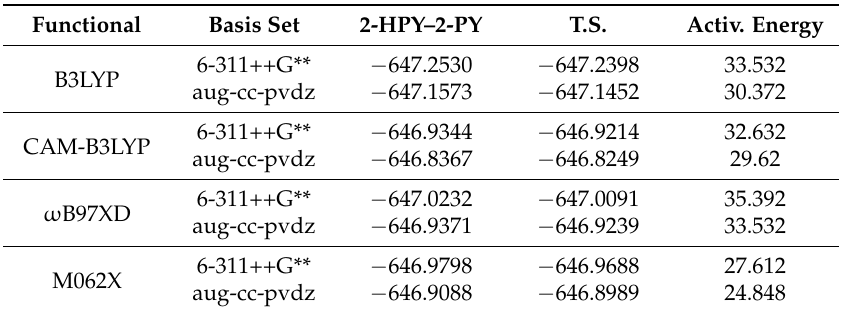
Table 3. The total energy (a.u.) of the mixed dimer (2-HPY–2-PY) and the transition state (T.S.) and the activation energies (kJ/mol) for the double proton transfer of the 2-HPY and 2-PY tautomers using different DFT) functionals with 6-311++G** and aug-cc-pvdz basis